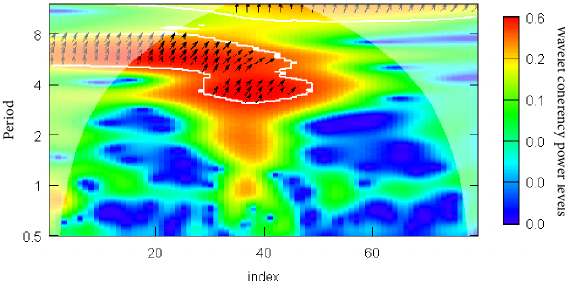
Figure 2. Wavelet coherence Euro area GDP growth rate and public debt